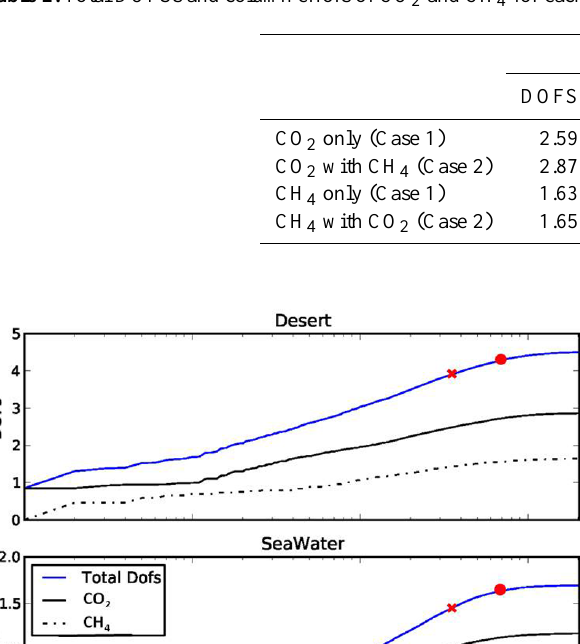
Table 2. Total DOFSs and column errors of CO 2 and CH 4 for each surface using all spectral channels.